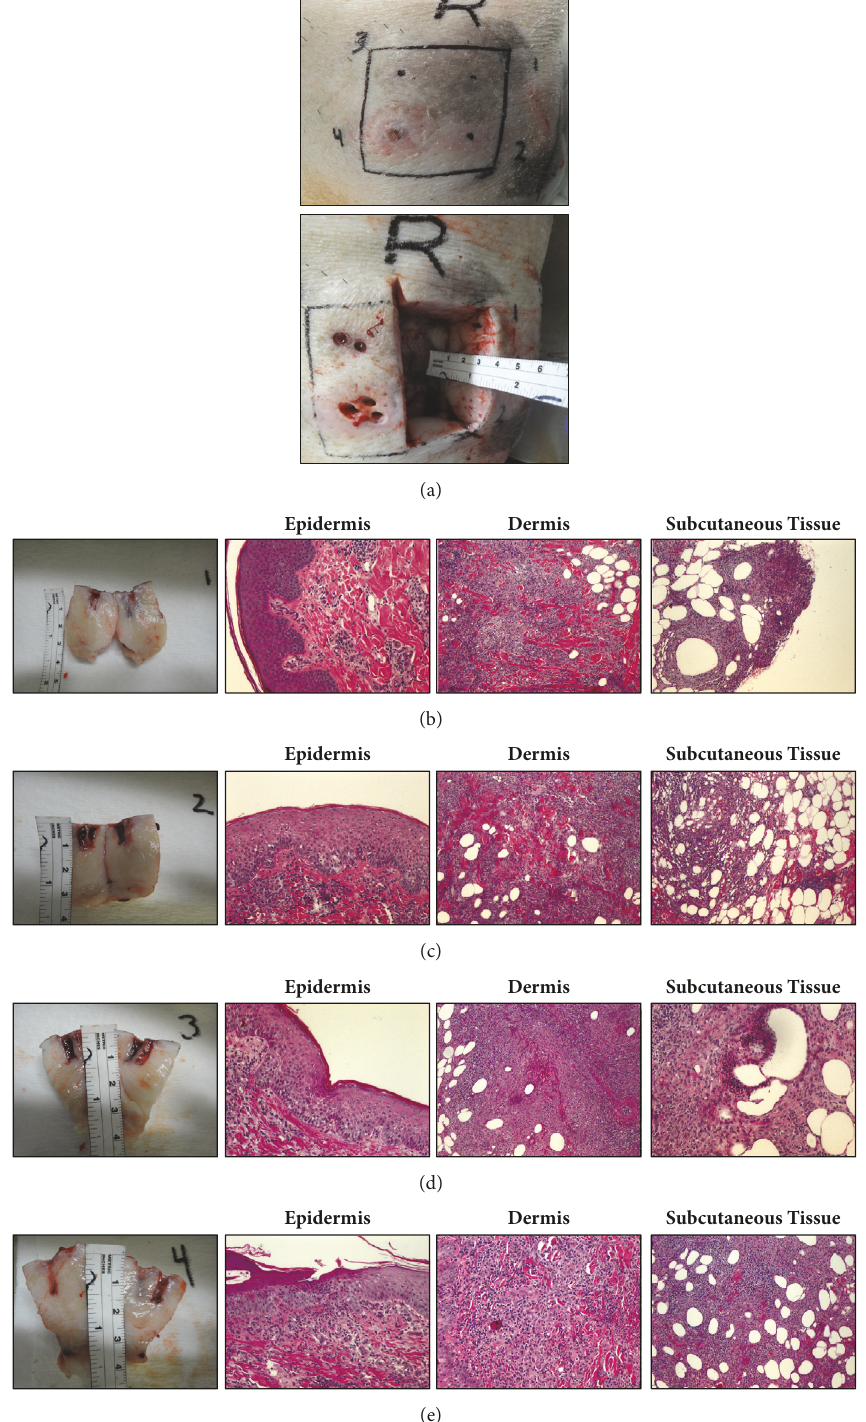
Figure 4: Macroscopic appearance of the skin following CFA injection into 4 different depths and picture of autopsy depicting the depth of the SC tissue in this particular animal (a). Figures (b–e), macroscopic and histologic appearance of the 4 different injection sites performed at different depths, demonstrating the inflammation in the different layers, epidermis, dermis, and SC